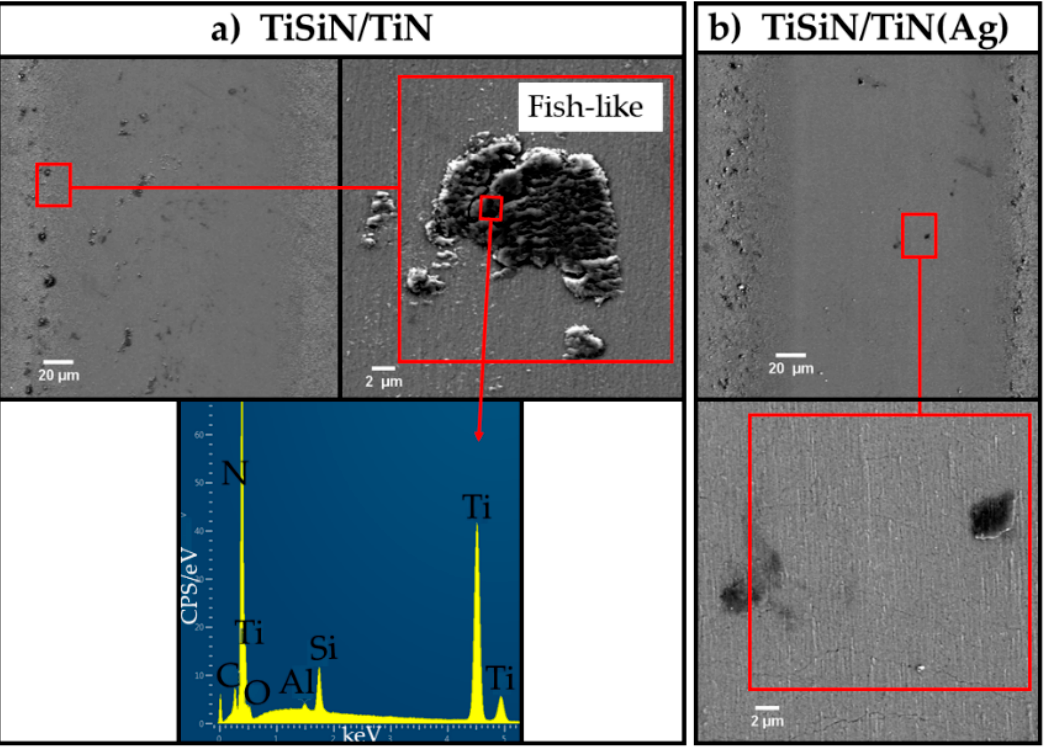
Figure 4. SEM micrographs of the wear tracks of the ( a ) reference and ( b ) Ag-alloyed coatings tested at RT against Al 2 O 3 balls. In ( a ), the EDS spectrum of the wear debris visible on the wear track of the reference coating is also shown.